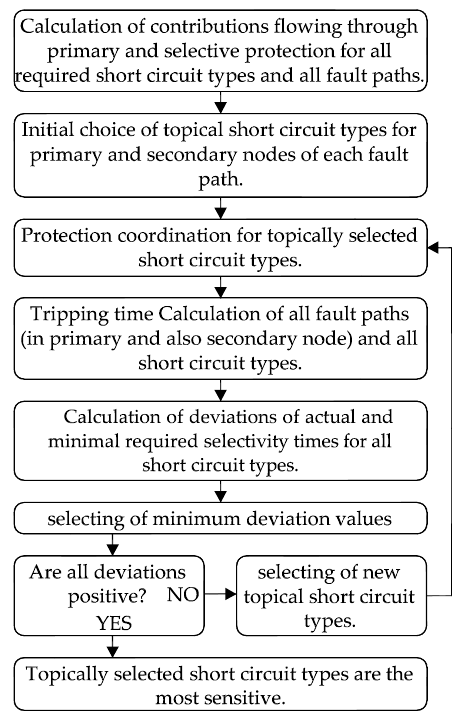
Figure 6. Finding process of the most sensitive short-circuit types.